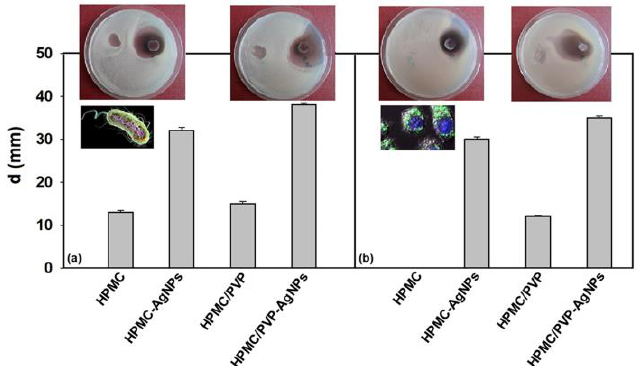
Figure 12. Antimicrobial activity expressed by the diameter of the inhibition zone, (d, mm) for studied materials against Escherichia coli ( a ) and Staphylococcus aureus ( b ) microorganisms. Pictures included represent the antimicrobial screening tests for evaluated materials. In each figure, the inhibition area on the right side was recorded for samples with embedded